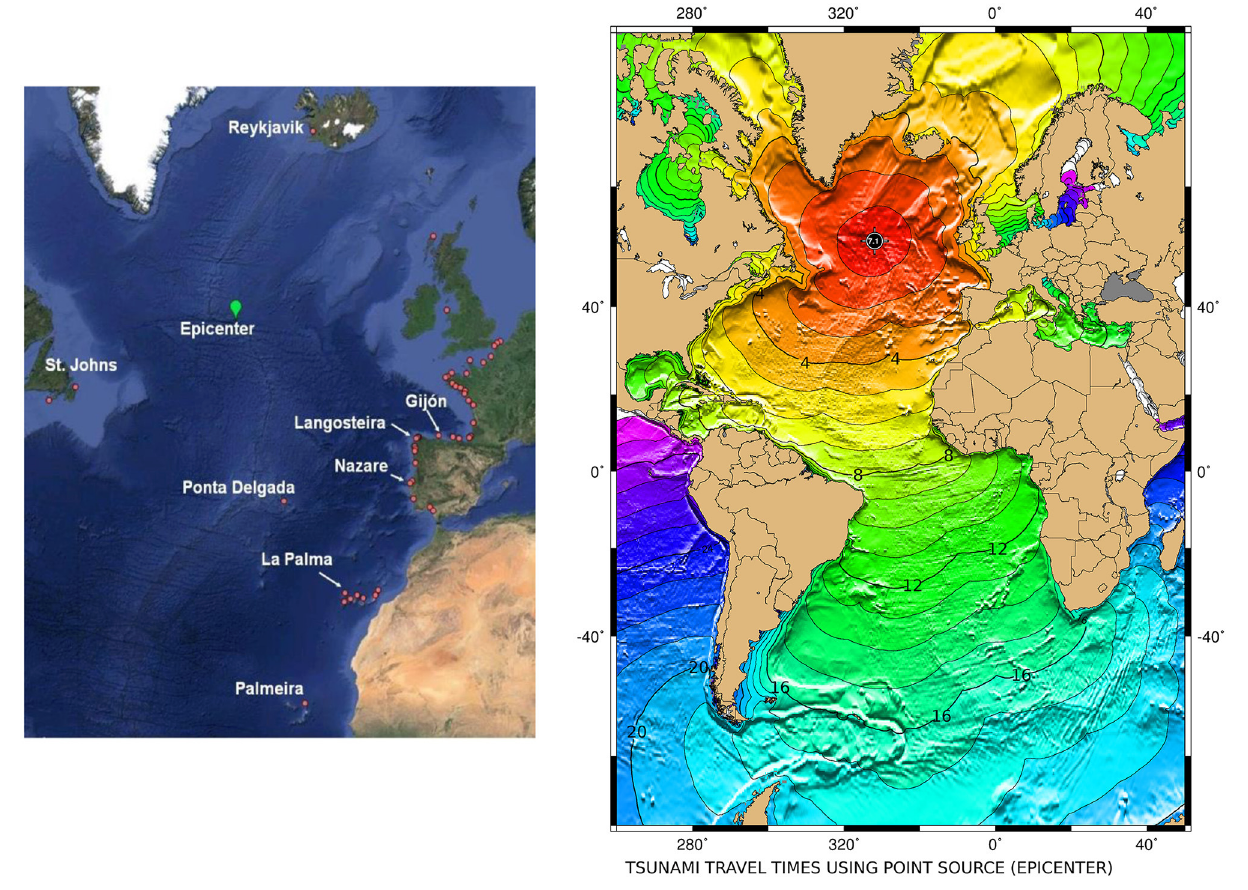
of the earthquake. Expected arrival times from the numerical simulation presented in Table 2 have been added by means of vertical black